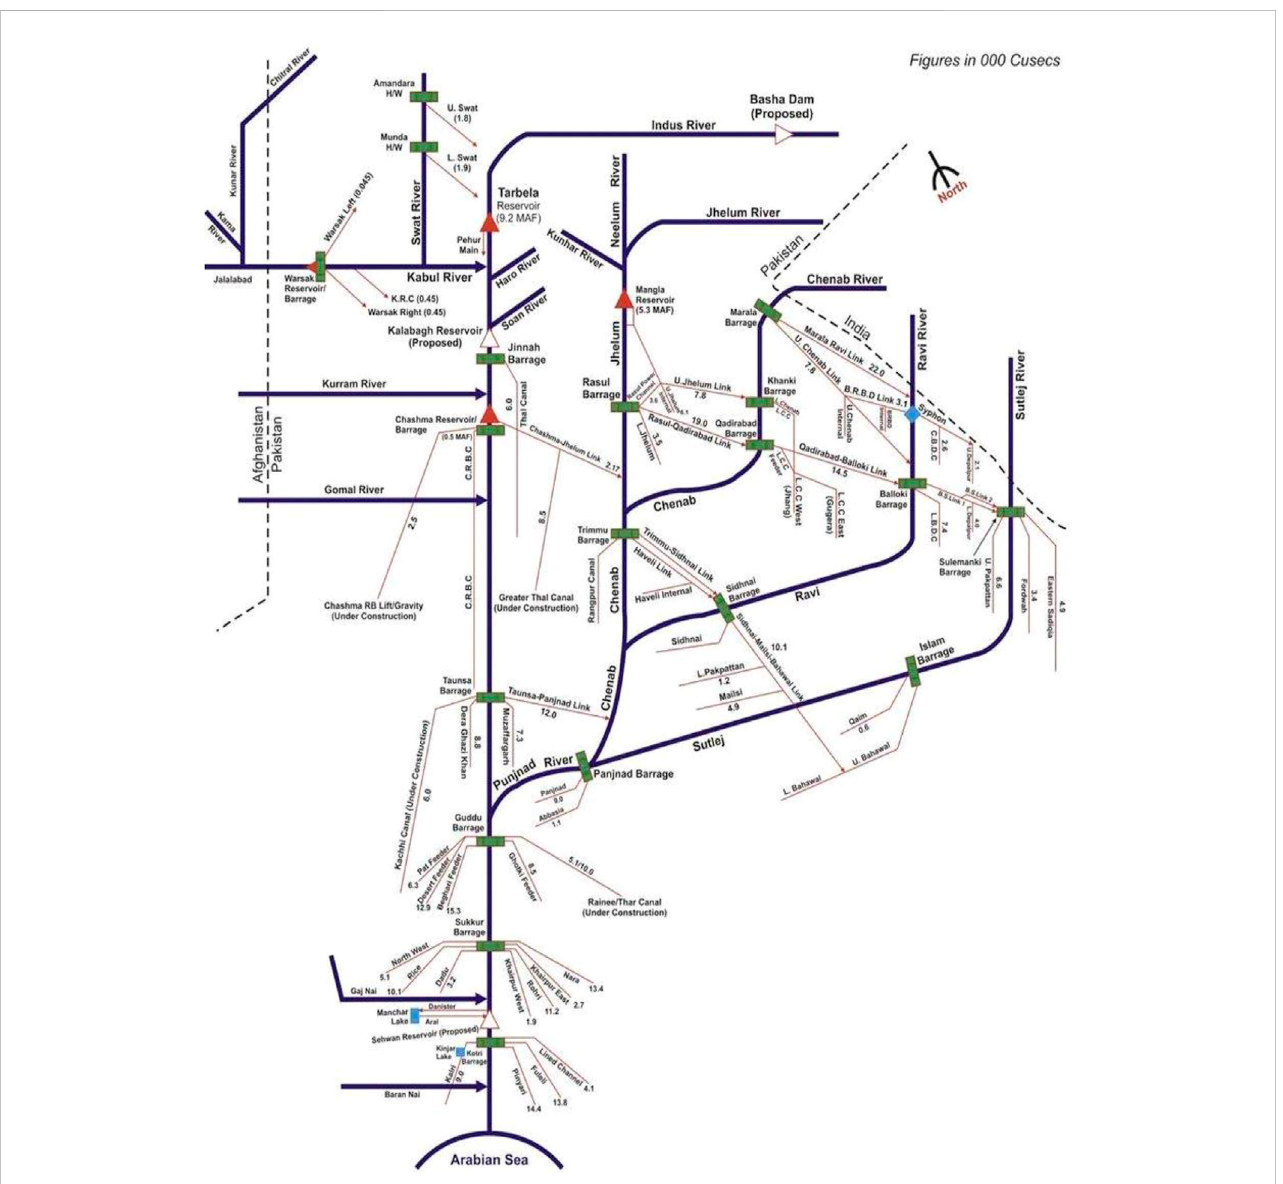
FIGURE 9 Indus basin irrigation system (IBIS) of Pakistan. Source ministry of planning and development (Iqbal, 2013) https://www.pc.gov.pk/uploads/plans/Ch20- Water1.pdf.